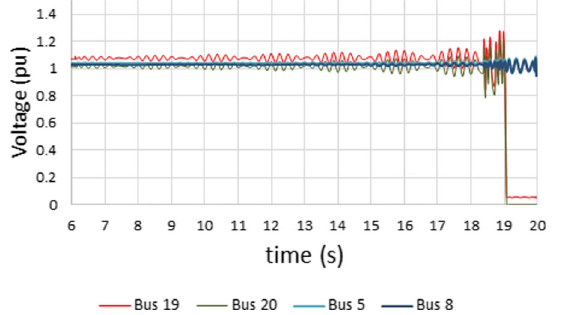
Fig. 18 Voltage profile post contingency